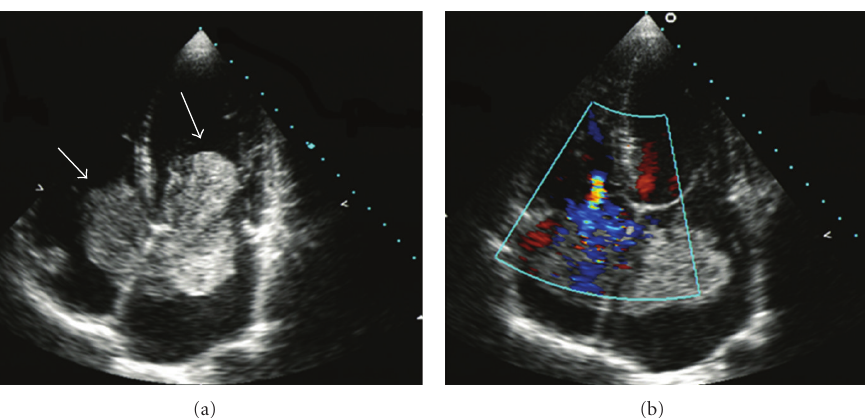
Figure 1: Echocardiogram showing bilateral atrial tumors (arrows), large left atrial mass protruding through the mitral valve during diastole. There was a mild tricuspid regurgitation on the color Doppler examination.